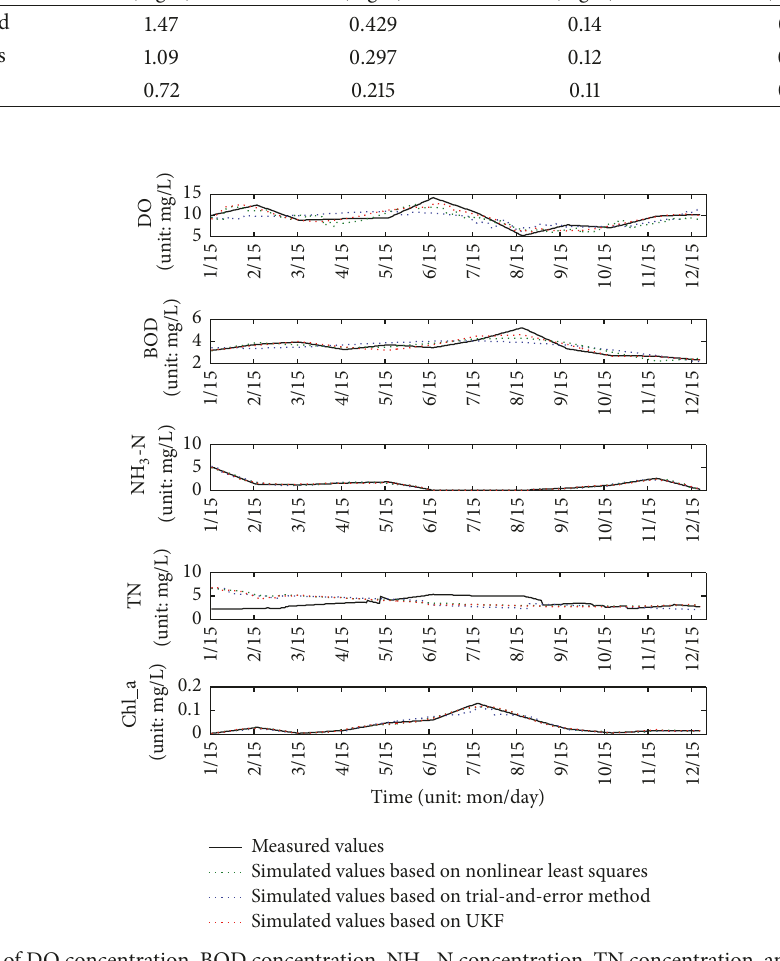
Figure 2: Results of DO concentration, BOD concentration, NH 3 -N concentration, TN concentration, and Chl a